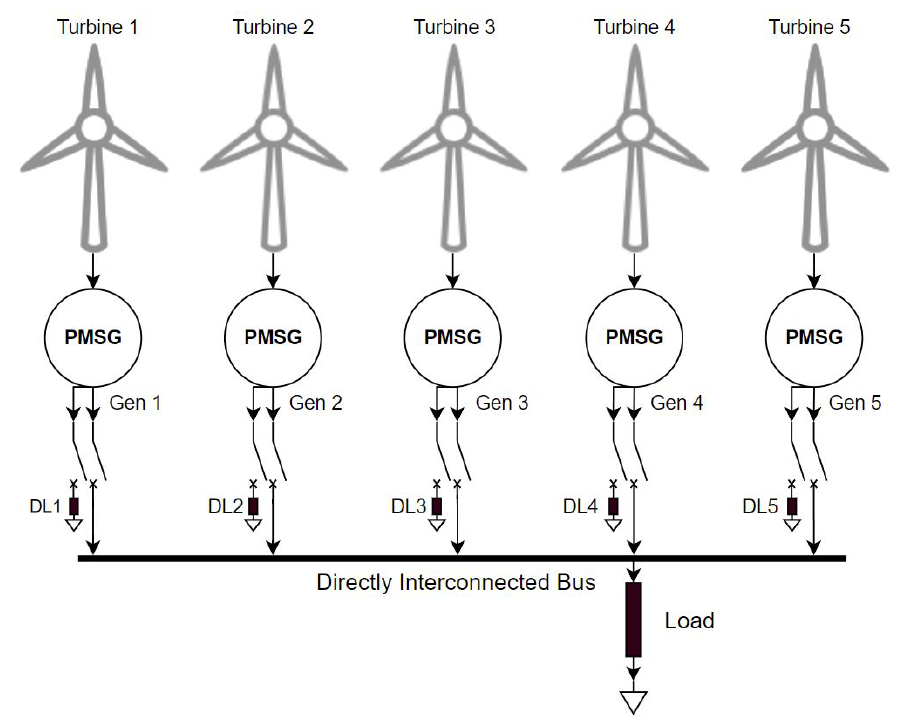
Figure 4. Simulation Diagram Showing the five turbines with their respective dump loads, the directly interconnected bus and the main load for the